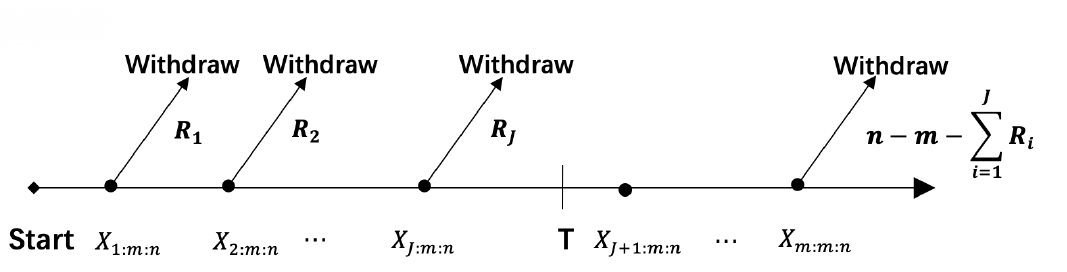
Figure 7. Progressive type-II censoring scheme.